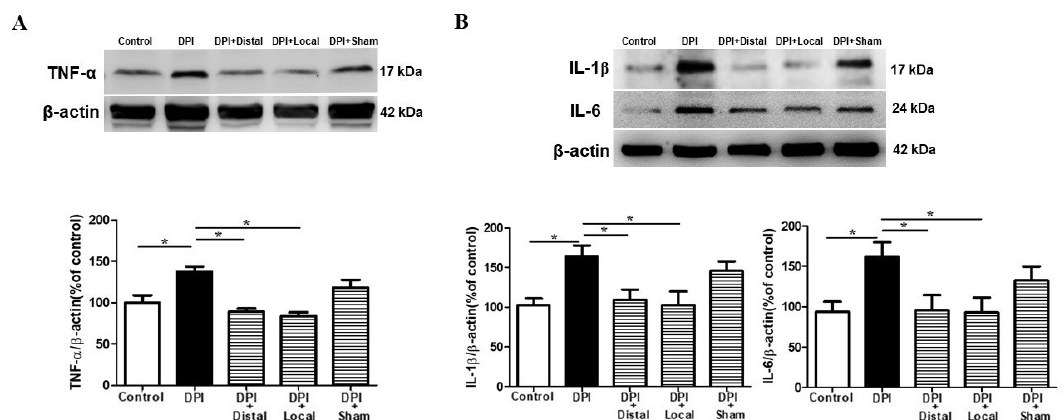
Figure 5. Verum (local and distal) EA inhibits DPI-induced production of pro-inflammatory factors in the Vc. All measured cytokines were markedly increased in the DPI group when compared with controls. ( A ) Verum (local and distal) EA, but not sham EA, reduced the production of pro- inflammatory cytokine TNF- α . ( B ) Verum (local and distal) EA but not sham EA, suppressed IL-1 β and IL-6 production in the Vc. Illustrative Western blot bands, histogram and data summary depicting TNF- α , IL-1 β and IL-6 expression. Between-group comparisons for each group were performed by ANOVA, followed by Dunnett’s test (* p < 0.05, versus DPI group; n = 7 in each group).